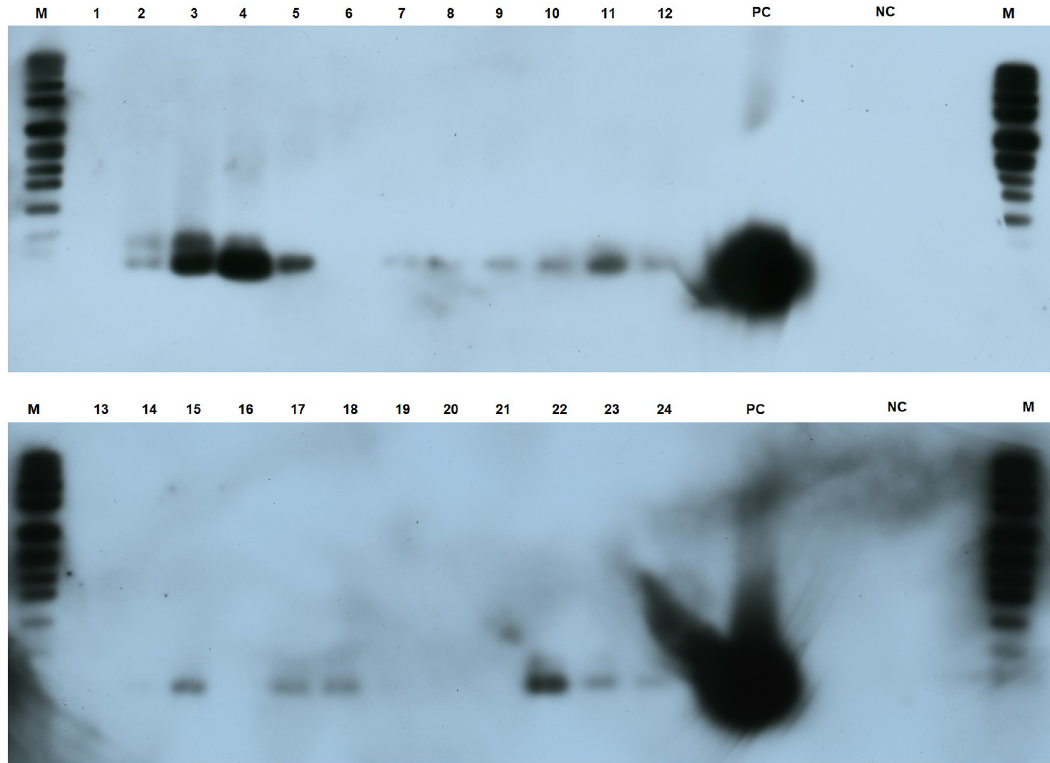
Fig 6. PCR-Southern blot using a probe for IncP-1 ε subgroup. Lanes: 1–3: Mowing/4 days; 4–6: Glyphosate/4 days; 7–9: Mowing/ 10 days; 10–12: Glyphosate/10 days; 13–15: Mowing/17 days; 16–18: Glyphosate/17 days; 19–21: Mowing/26 days; 22–24: Glyphosate/26 days; M = marker DIGVII; PC: positive control (amplification product of IncP-1 ε plasmid pKJK5); NC: negative control. Exposure time: 30 min. In those lanes in which no bands were detected, the same result was observed after a longer exposure time. Size of the smallest band of DIGVII marker: 359